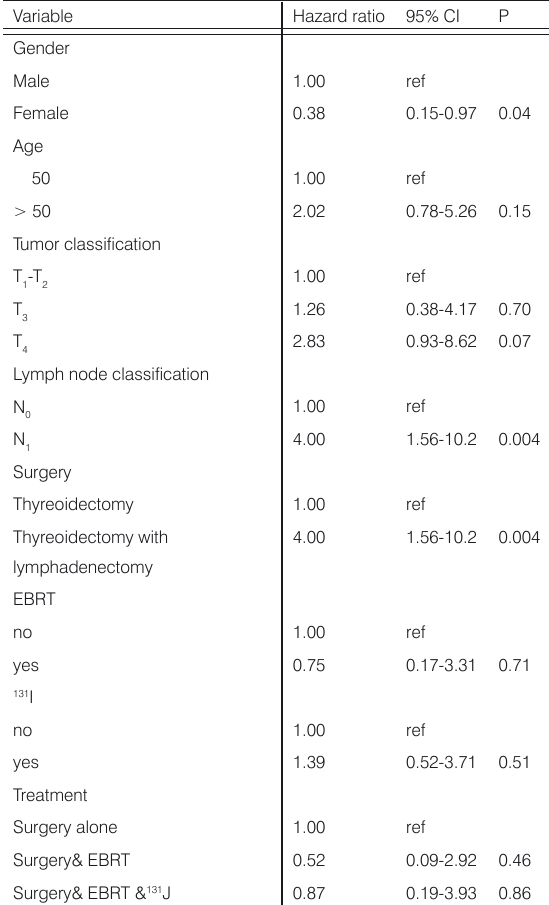
Table 2. Prognostic factors on long term survival of MTC patients (univariate analysis).